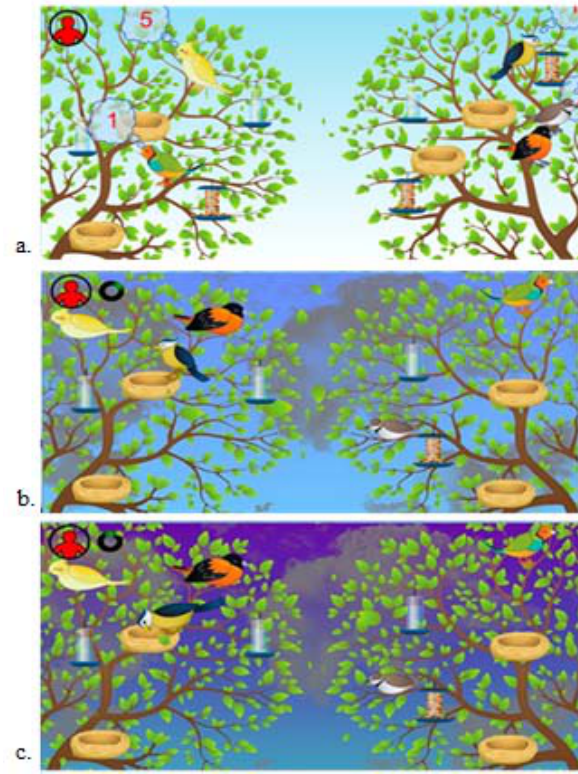
Figure 2. The three different levels of students sleep efficiency daily average: a) clear and sunny sky corresponds to a medium-high value of sleep efficiency average, b) cloudy sky represents a medium-low value of efficiency average, c) the sky become dark when the sleep efficiency average is very low.